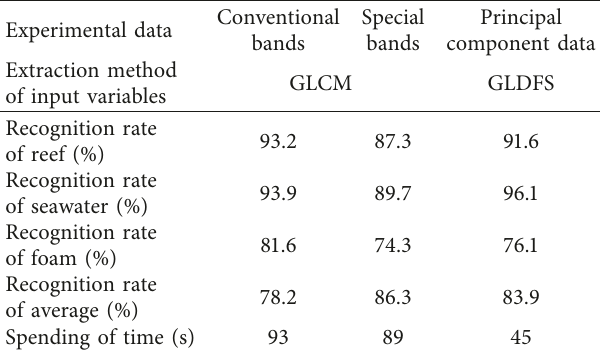
Table 3: The comparision of SVM multisclassification efficiency. Experimental